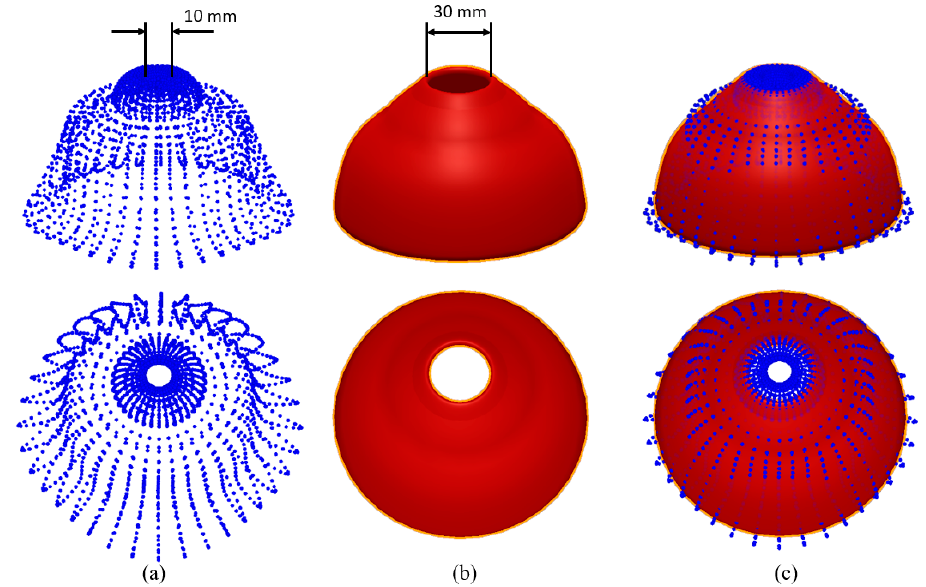
Figure 4. The difference ( c ) between the reconstructed surface ( a ) and the original surface ( b